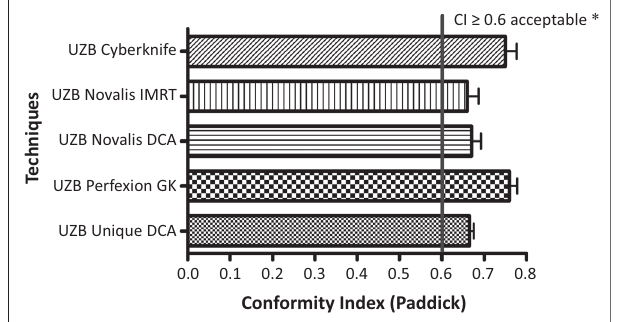
Conformity Index (Paddick)